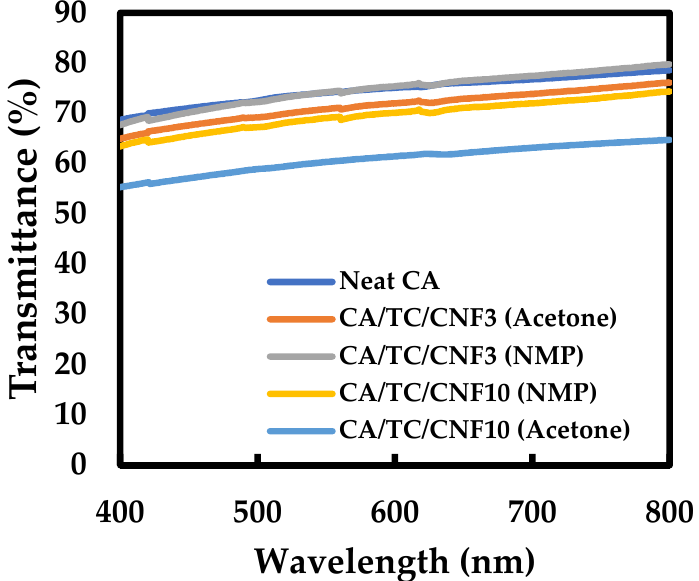
Figure 4. Visible light transmittance of CA films containing different ratios of CNF prepared using acetone and NMP solvent.